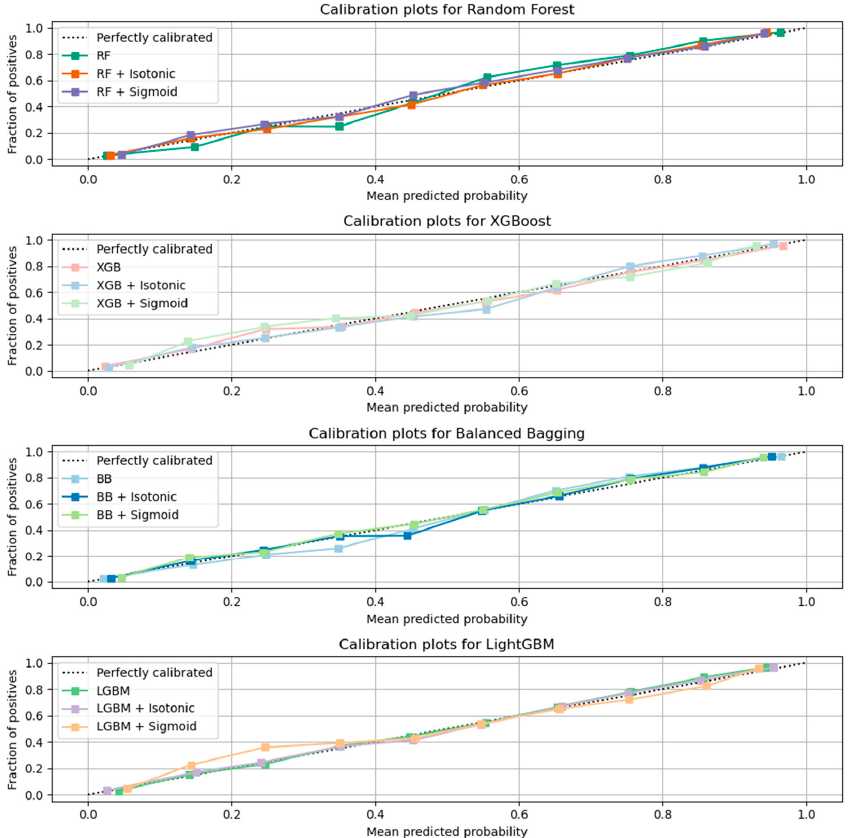
Figure 3. Calibration results for each classifier with comparative performance based on AUC results.